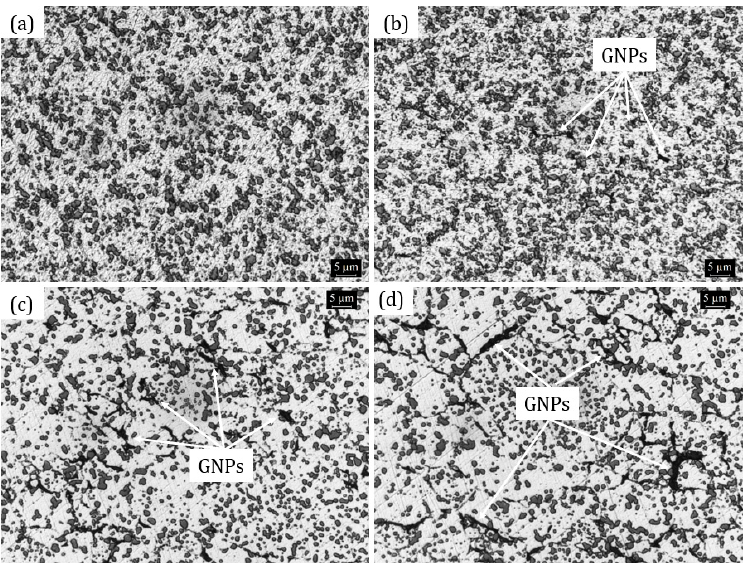
Figure 3. Light micrographs of ( a ) AlSi10Mg, ( b ) AlSi10Mg–0.5 wt.% GNPs, ( c ) AlSi10Mg–1 wt.% and ( d ) AlSi10Mg–2 wt.% GNPs after hot consolidation perpendicular to the compaction direction. Figure 4a-d is the Optical micrographs of AlSi10Mg– x GNPs ( x = 0, 0.5, 1.0, 2.0 wt.%). These